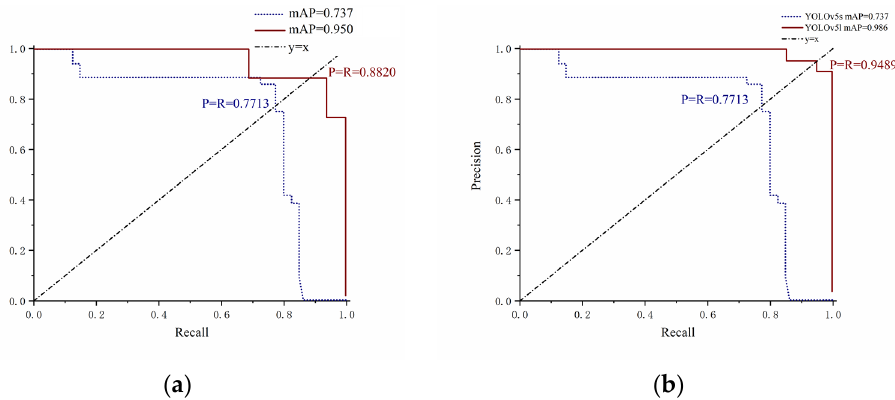
Table 3. Training results of test sets consisting of simulated ship wakes in different sea states.